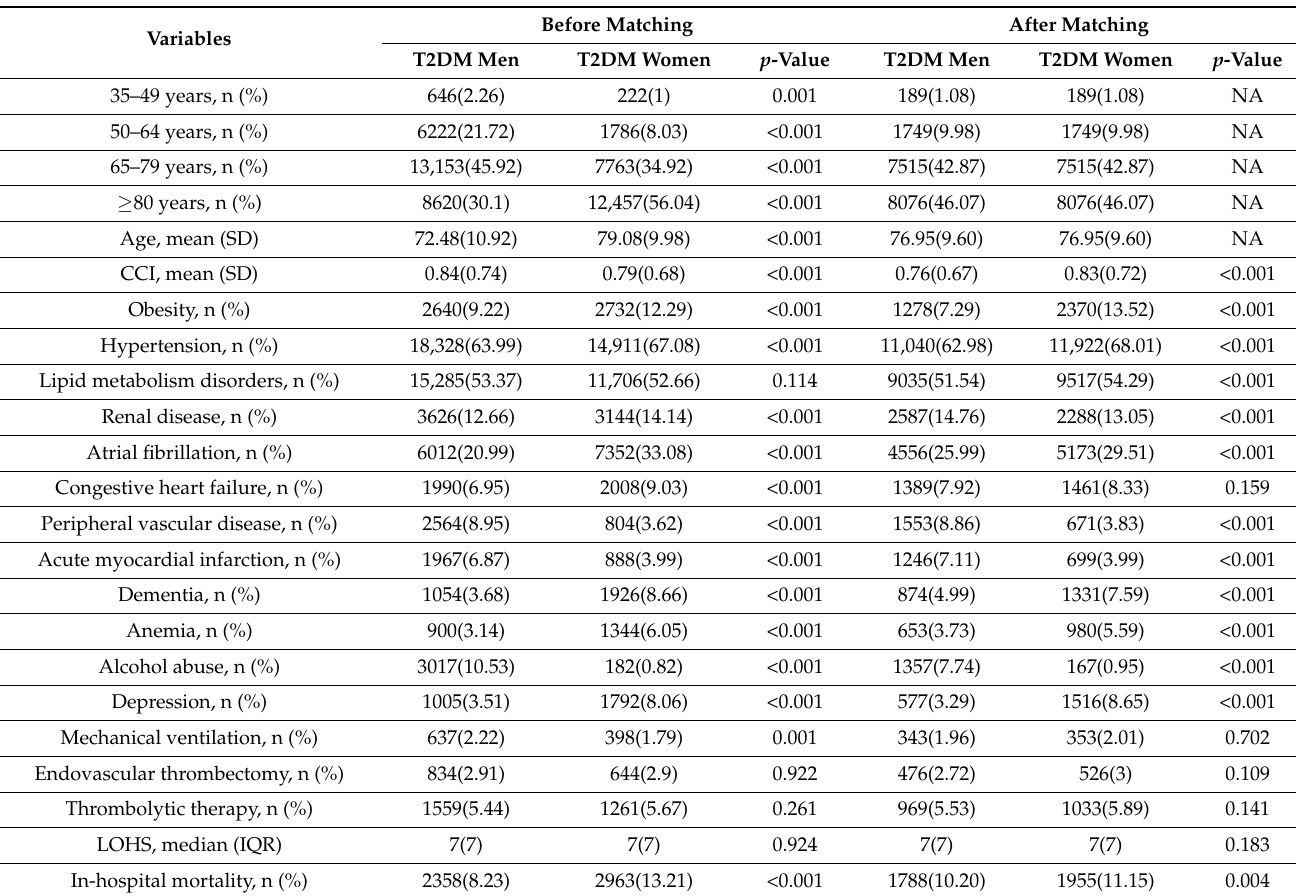
Table 4. Clinical characteristics, use of therapeutic procedures, and hospital outcomes before and after matching by age (ICD 10) after ischemic stroke among patients with T2DM according to